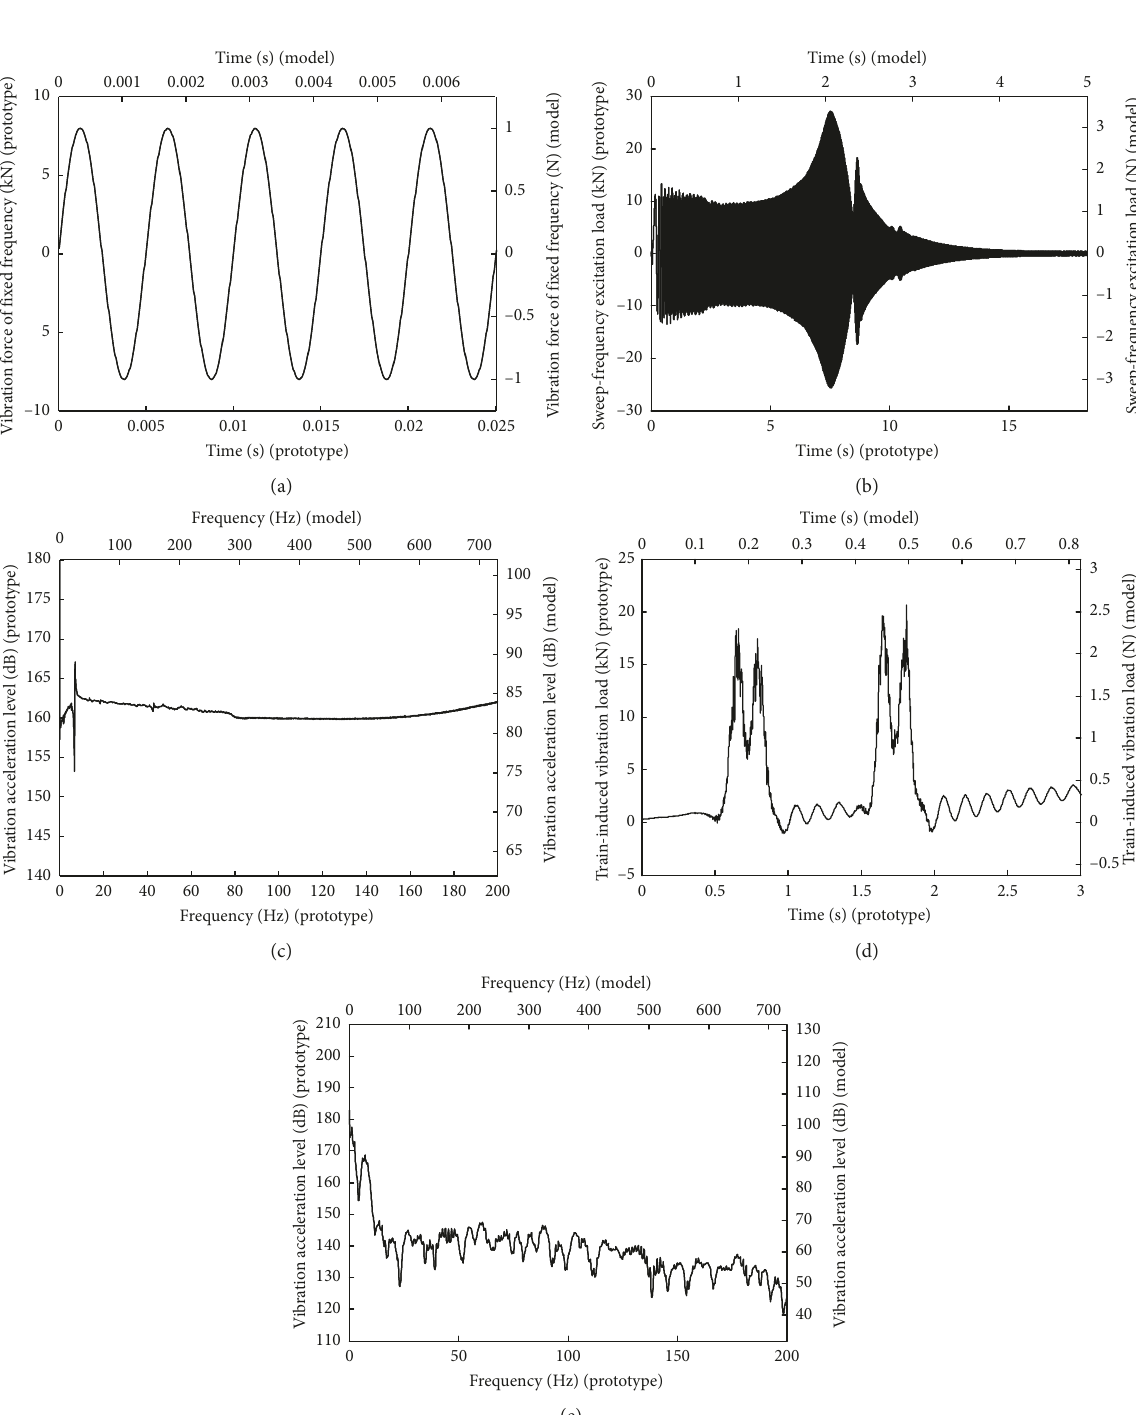
Figure 4: Dynamic loads applied in the experiment. (a) Sinusoidal loads at a fixed-frequency 200Hz (prototype scale). (b) Sweep loads in time domain. (c) Sweep loads in frequency domain. (d) Train loads in time domain. (e) Train loads in frequency